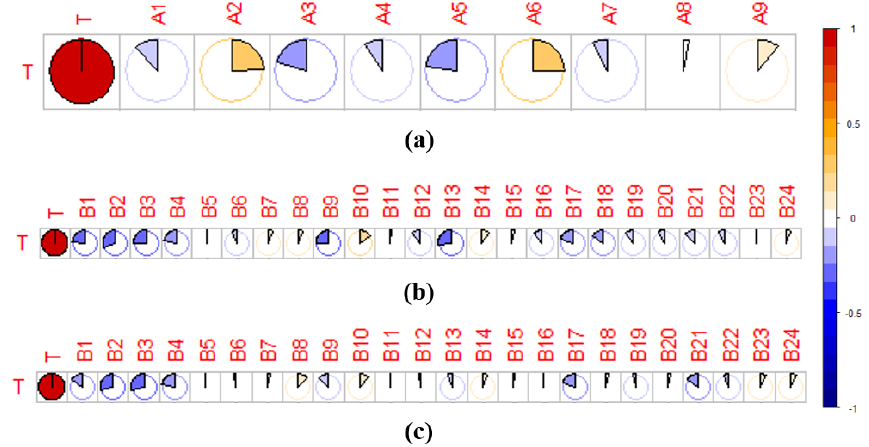
Figure 14. Pearson correlation coefficient between the response time with catchment features and variation in climate variables before and after the change point. (a) Correlation between the response time and catchment features; (b) correlation between the response time and absolute change in climate variables; (c) correlation between the response time and relative change in climate